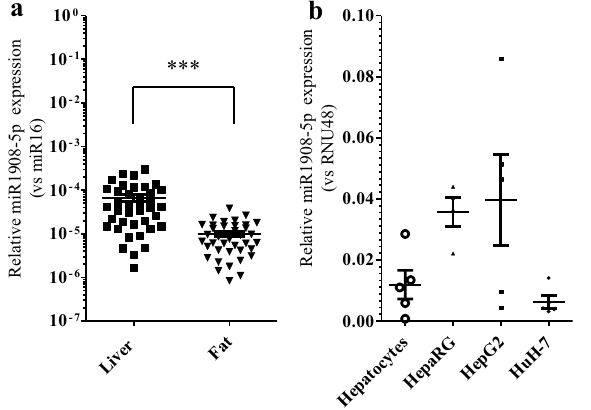
Figure 1. miR1908-5p abundance in hepatocyte models and human biopsies. ( a ) miR1908-5p expression in liver and omental fat biopsies. The difference between adipose and liver was highly significant ( p < 0.0001, t-test). Values are expressed relative to the average abundance of RNU48 (miR16 was not detectable in primary hepatocytes). ( b ) miR1908-5p expression in hepatocytes and HCCs. Values are expressed relative to the abundance of miR16 (RNU48 detection was inconsistent). Data represent the average of 4–5 biological replicates for HCC (± SEM). Means across cell types were statistically significant (1 way ANOVA, p = 0.03), but no pair passed Tukey’s post-hoc multiple comparison test.